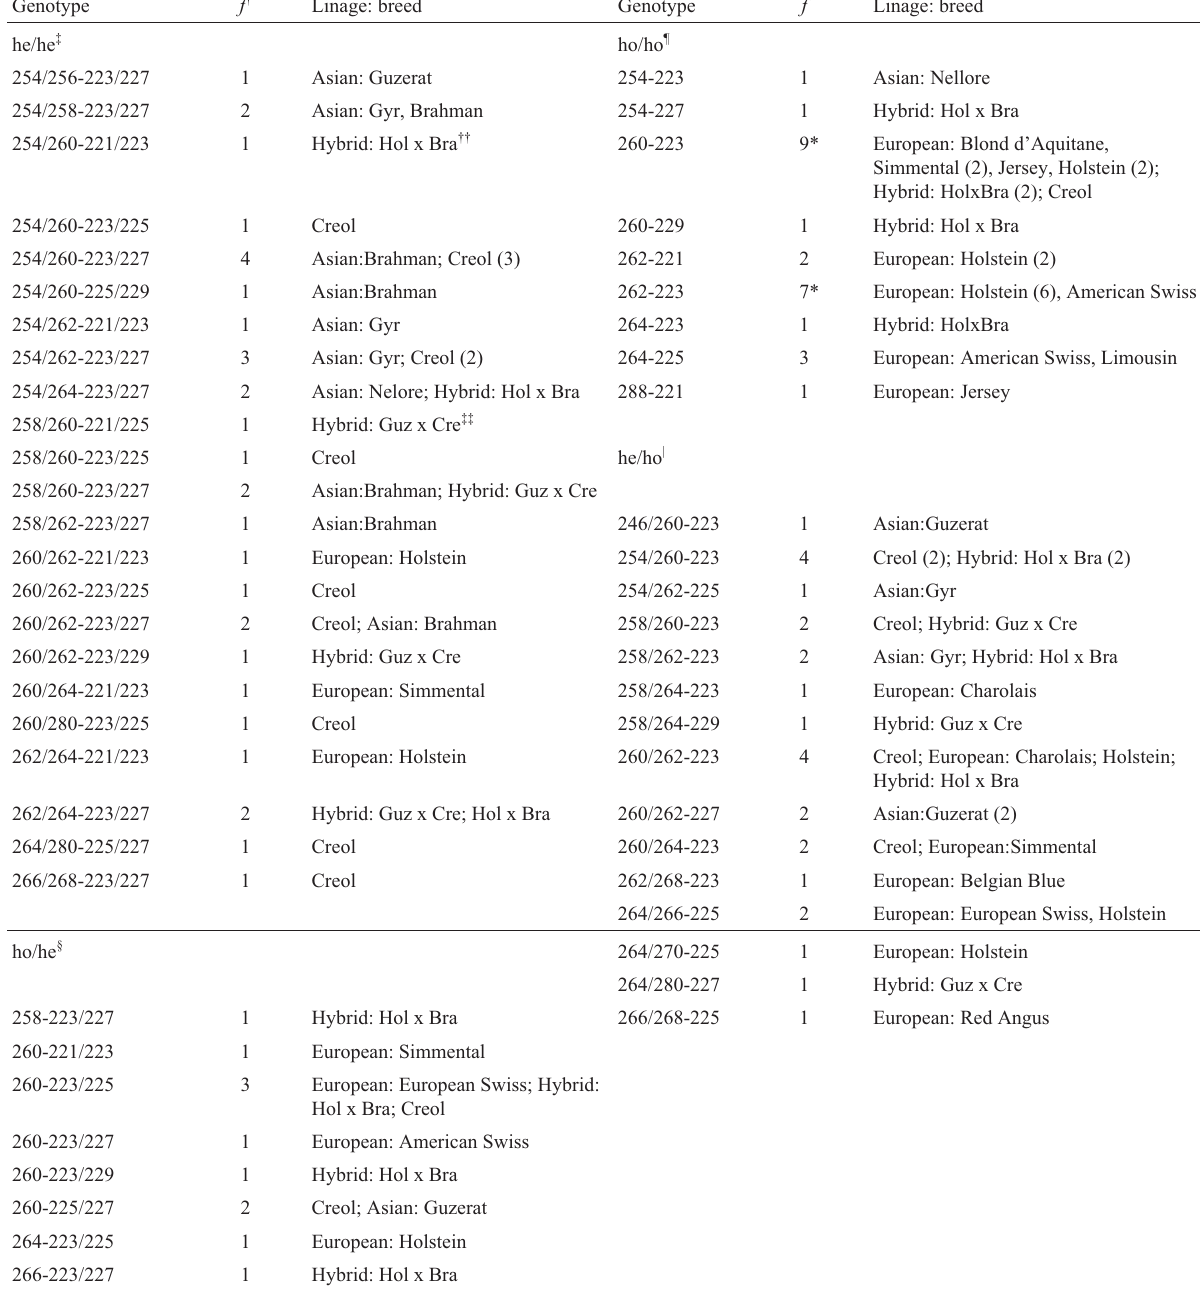
Table 2 - Genotypes identified in the entire population.